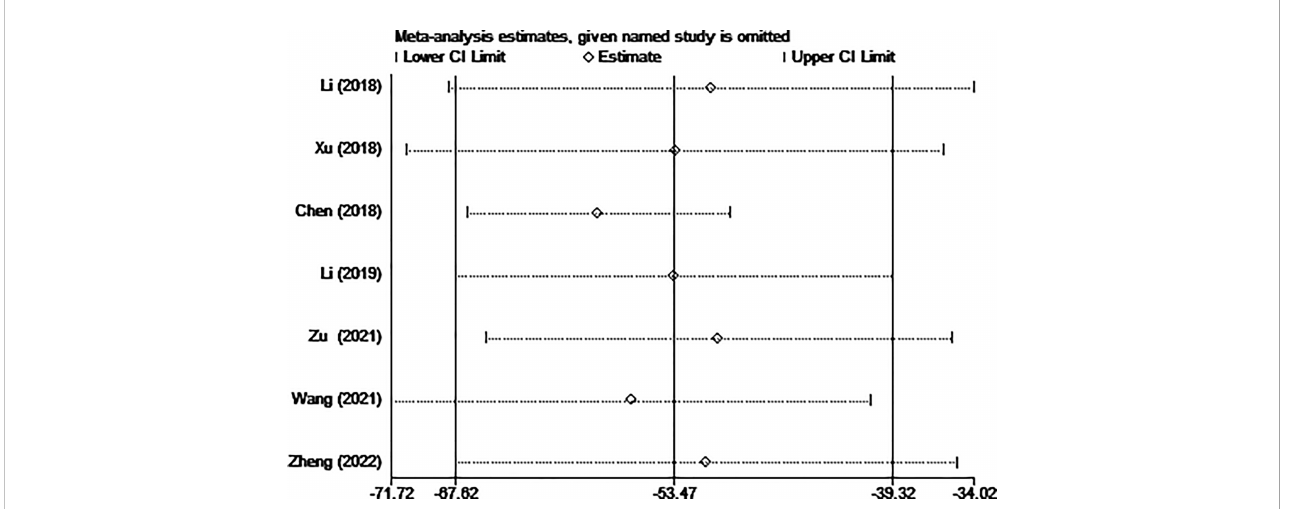
FIGURE 11 Sensitivity analysis of operation time for comparing MWA with surgery in patient with PTMC. MWA, microwave ablation, PTMC, papillary thyroid